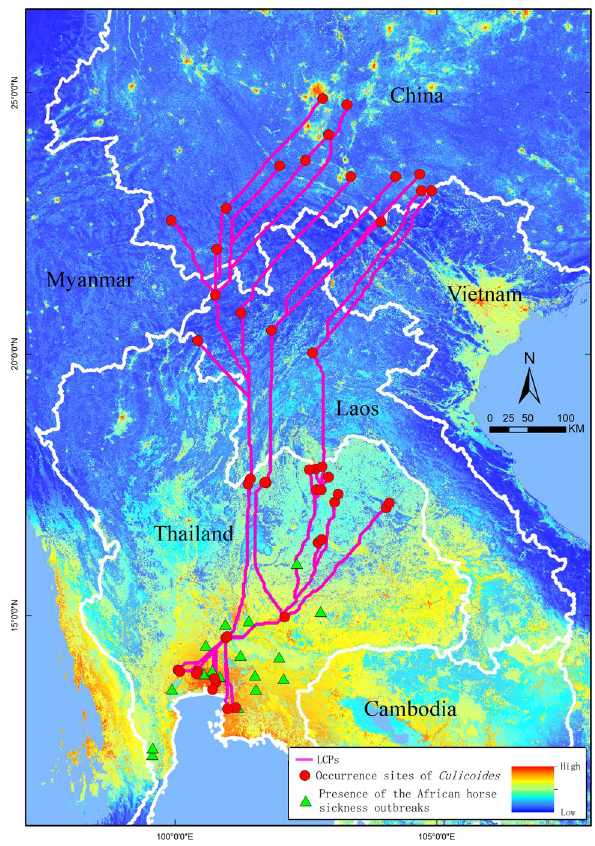
Figure 2. AHS and Culicoides overlying high-risk areas and transboundary Least Cost Paths for Culicoides . This map was made in ArcGIS 10.6 using the resulting rasters produced by MaxEnt. Red circle means occurrence sites of Culicoides and green triangle means African horse sickness outbreaks in the research area.occurrence sites of Culicoide. The pink lines shows the LCPs between of Culicoides . The boundary was obtained from Natural Earth (http:// www. natur alear thdata. com/), which is a schematic line illustrating the relative position of each country and should not be re-used or misinterpreted for any political